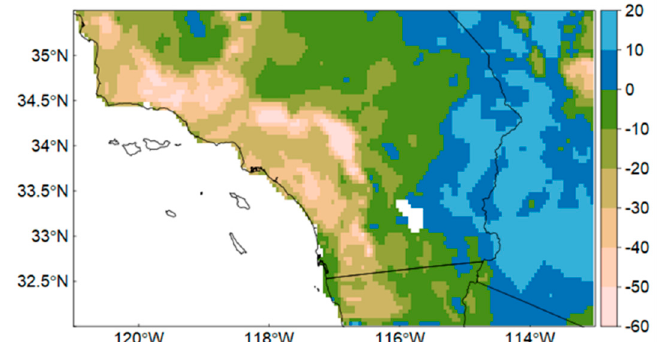
Figure 7. 2007–2016 monthly average TWS anomaly simulated by the fully-coupled model. Anomalies calculated based on the 2007–2010 average baseline. Unit: mm.